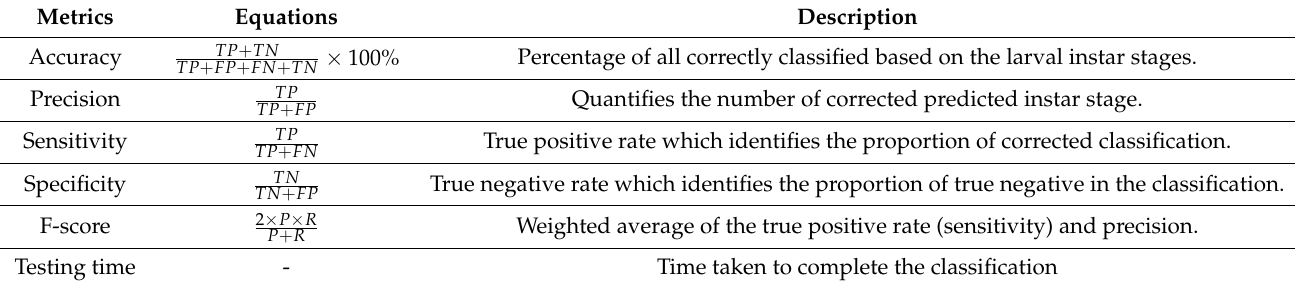
Table 4. The performance metrics with brief